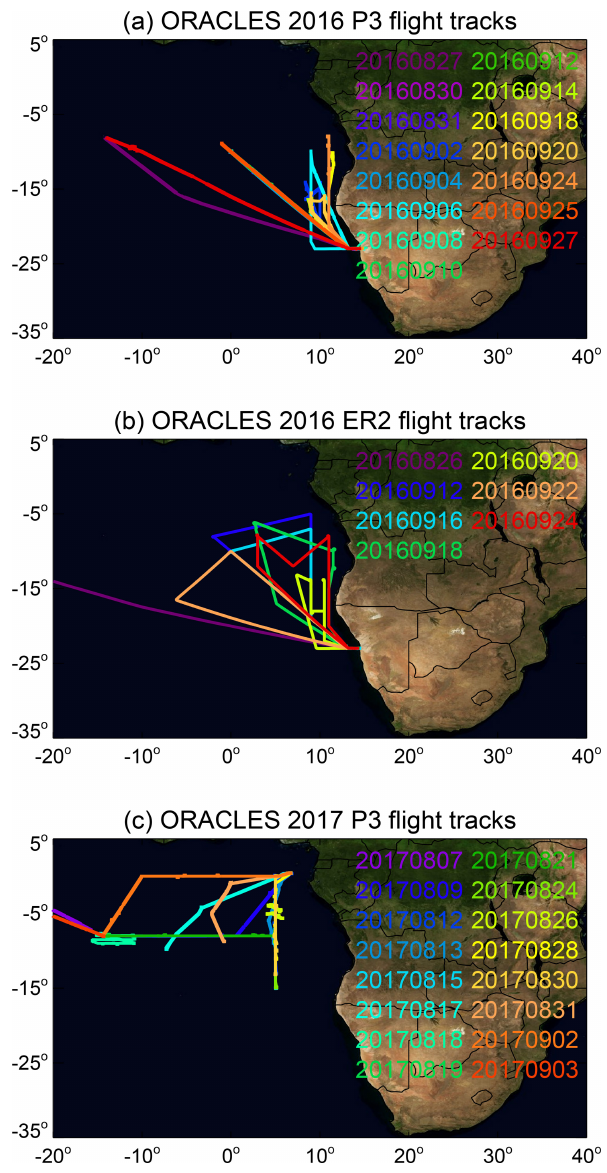
Figure 5. Flight tracks for the 2016 and 2017 ORACLES deploy- ment, coloured by date. From top to bottom, panels indicate the 2016 P3, 2016 ER-2, and 2017 P3 aircraft flight